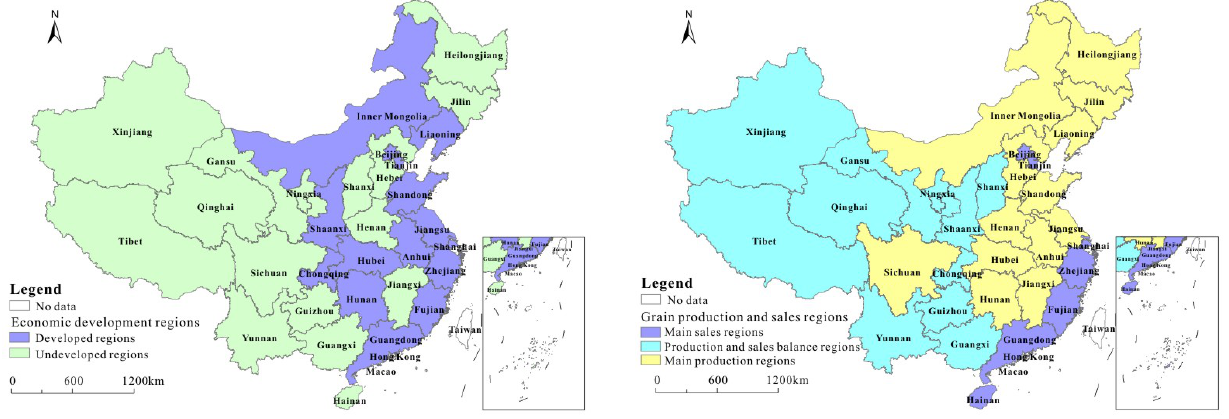
Figure 1. The spatial distributions of regions with different levels of economic development and grain production and sales.